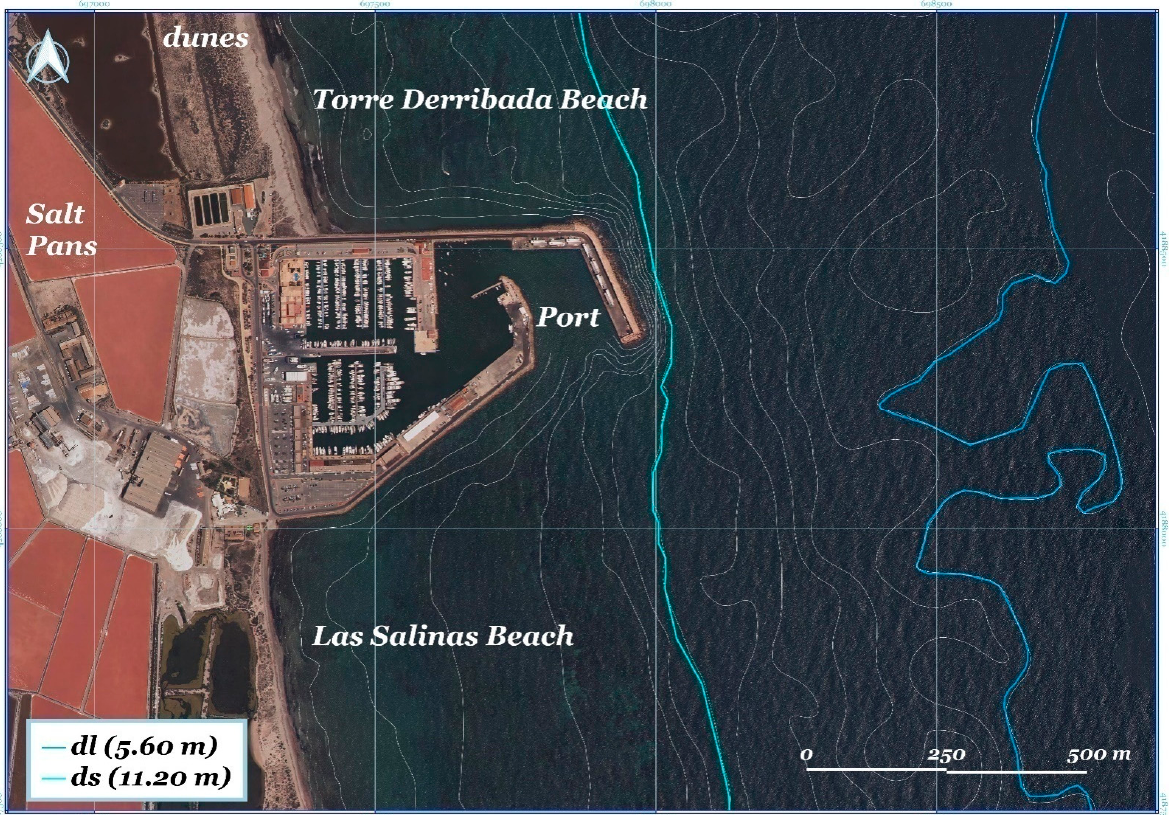
Figure 2. Coastal depth and shoal in the surroundings of the Port of San Pedro del Pinatar. Source: own elaboration.